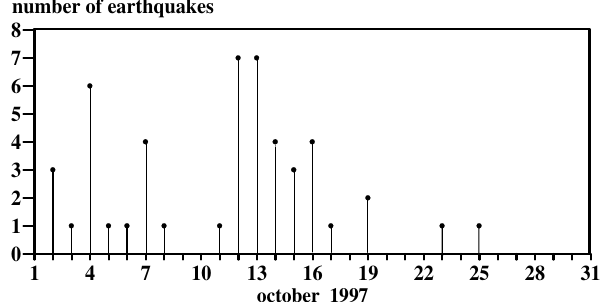
Fig. 3. Occurrence frequency of EQs with M> 4 occurred in Octo- ber 1997 at Central Italy.